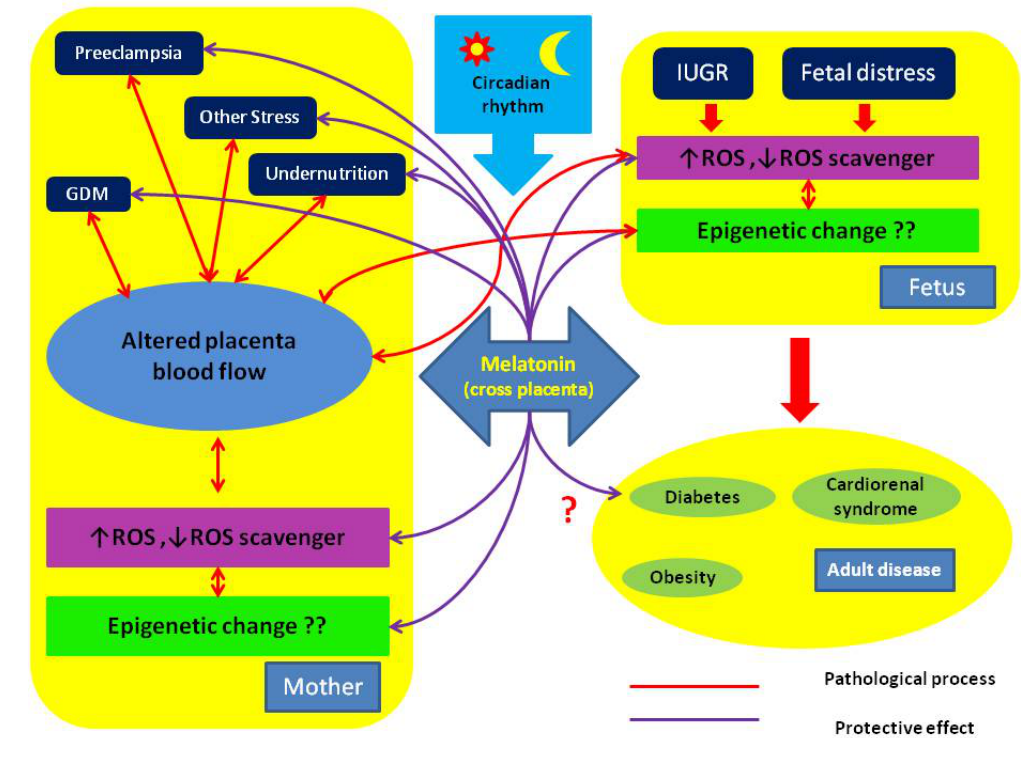
Figure 1. The proposed pathways showing how melatonin can affect normal and compromised pregnancies and result in different adult phenotypes. Melatonin can reduce ROS in both mother and fetus and alters fetal programming in compromised pregnancies through epigenetic changes. GDM (gestational diabetes mellitus); IUGR (intrauterine growth retardation); ROS (reactive oxygen